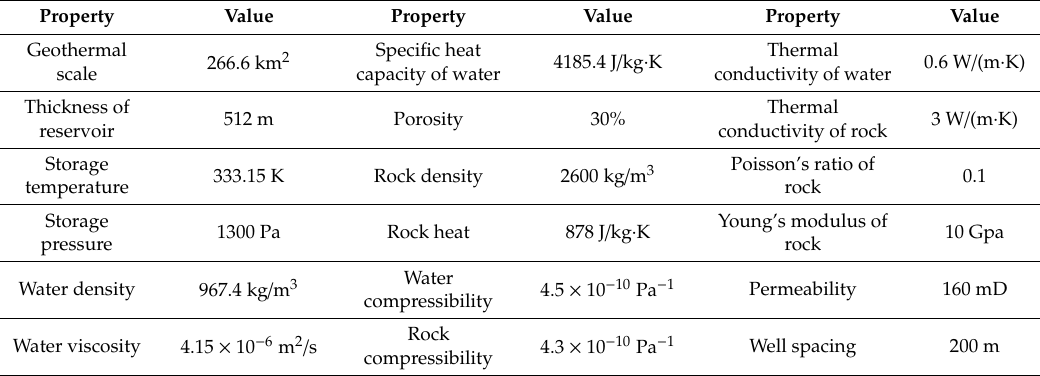
Table 1. Thermal–hydraulic–mechanical parameters for the base case of the Xinji geothermal reservoir.